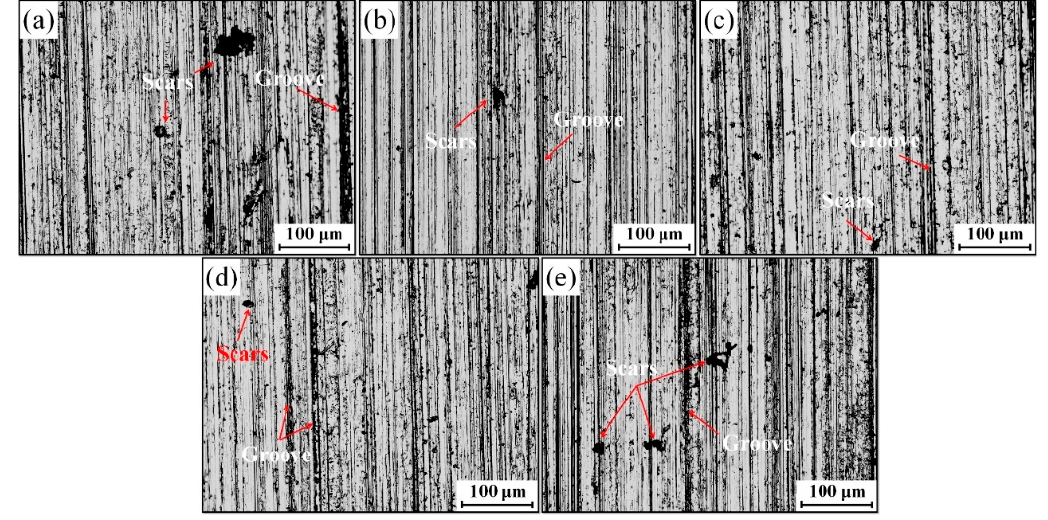
Figure 12. Worn surface image of the coating samples: ( a ) HSC0, ( b ) HSC02, ( c ) HSC04, ( d ) HSC06,